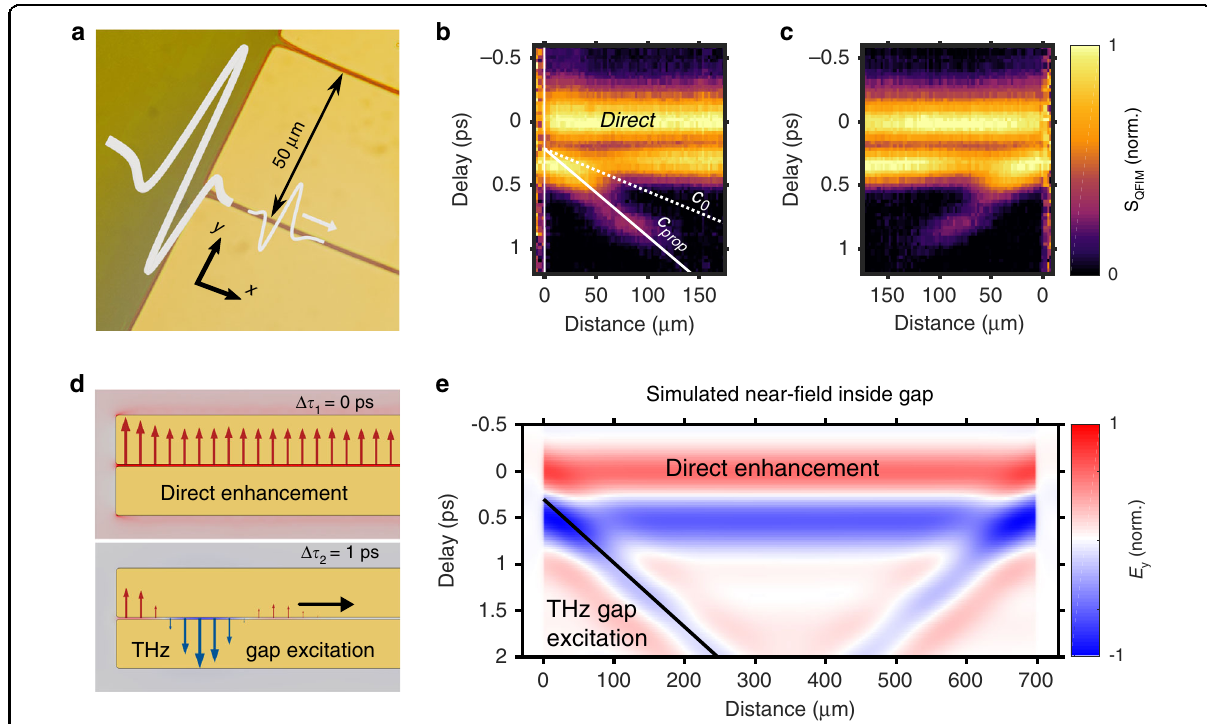
Fig. 4 Temporal imaging of a propagating THz gap excitation. a Launching of a THz waveguide excitation in a micro-slit driven at normal incidence (2µm gap). b 2D representation ( x , Δ τ ) of the normalized QFIM waveforms along the slit temporally disentangles the spatially homogeneous direct response of the slit (direct fi eld enhancement) and a THz gap excitation propagating along the waveguide. The peak electric fi eld inside the waveguide propagates with a velocity below c 0 (dashed line) as quantitatively predicted by time-domain electromagnetic simulation ( c prop , solid line). c The reversed propagation direction is observed via QFIM for excitation at the opposite side of the waveguide. d Simulated electric fi eld distributions for two temporal delays illustrate the homogeneous direct enhancement ( Δ τ 1 = 0 ps) and the propagating THz excitation ( Δ τ 2 = 1 ps). e 2D representation ( x , Δ τ ) of the simulated electric fi eld evolution along the gap in correspondence to ( b , c